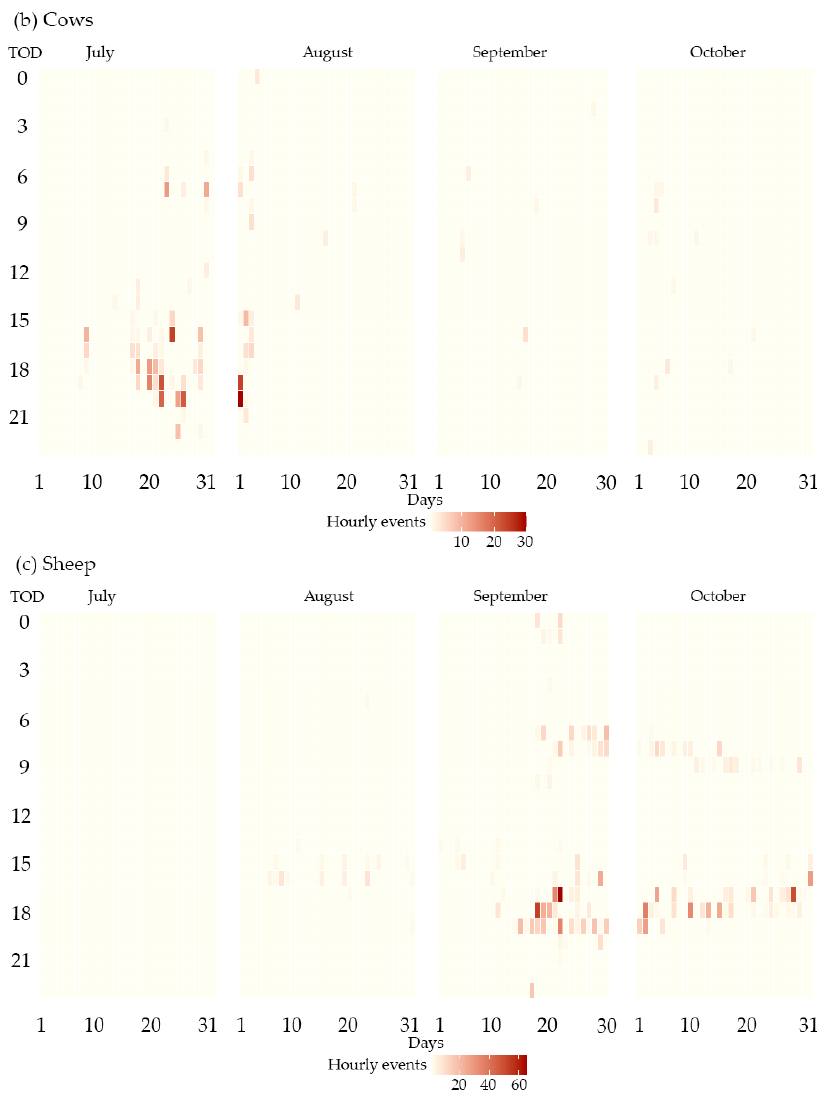
Figure 2. Diel and seasonal distribution of livestock bells ( a ), cow lowing ( b ), and sheep/goat bleats ( c ) at Livaditis site. Y-axis rows represent time of the day (TOD; 0 am to 23 pm). X-axis columns represent days of the study period (1 July to 31 October).